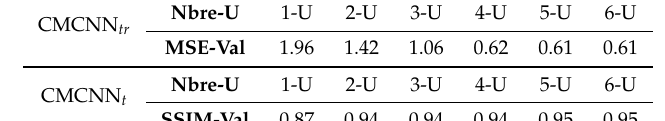
Table 2. Number of D-units and their corresponding average values of MSE and SSIM in each subNetwork.